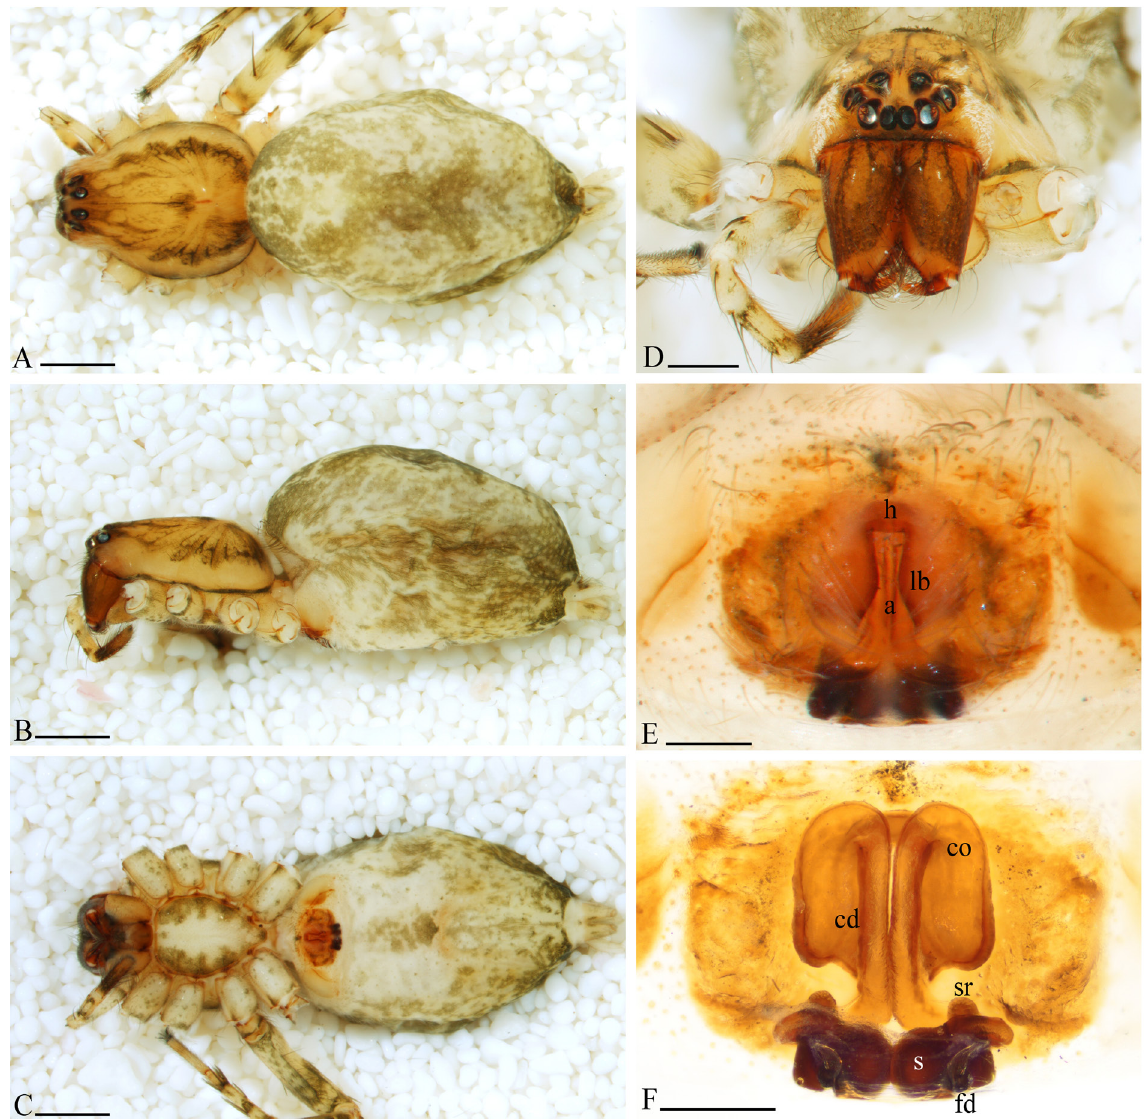
Fig. 43. Anyphaena ibarrai sp. nov., holotype, ♀ (CNAN-T01528). A . Dorsal habitus. B . Lateral habitus. C . Ventral habitus. D . Prosoma, anterior view. E . Epigynum, ventral view. F . Epigynum, dorsal view. Scale bars: A–C = 1.0 mm; D = 0.5 mm; E–F = 0.2